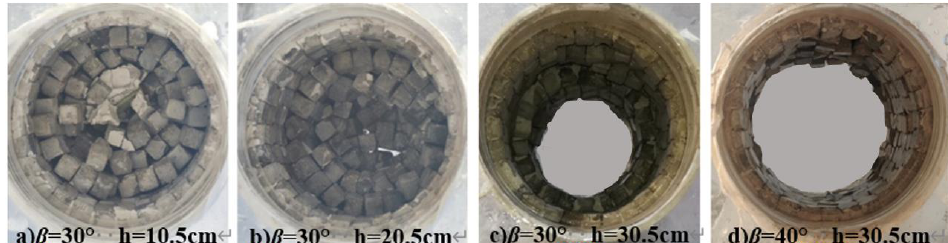
Figure 9. The effects of rock-plug blasting with different opening angles and heads of water.